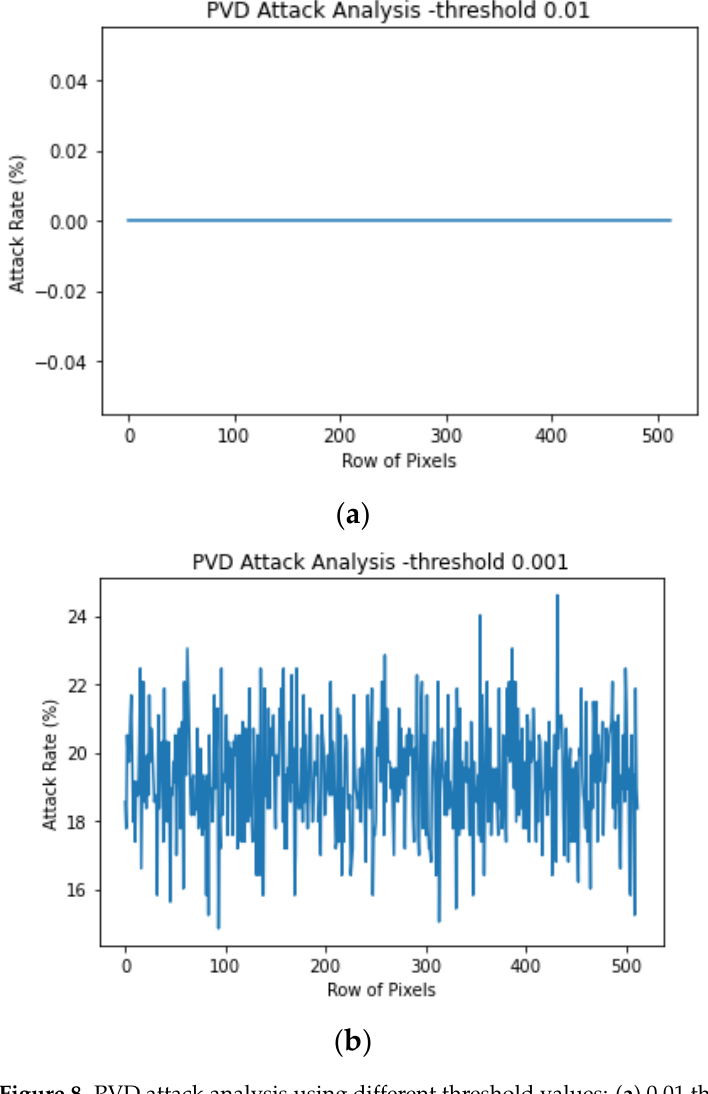
Figure 8. PVD attack analysis using different threshold values: ( a ) 0.01 threshold, ( b ) 0.001 threshold. An entropy graph represents the entropy values of two images or distributions. Entropy is a measure of uncertainty or randomness in a signal, image, or